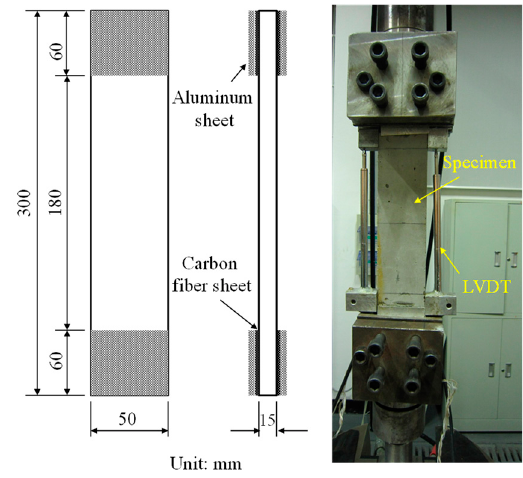
Figure 2. Uniaxial tensile specimen and test.